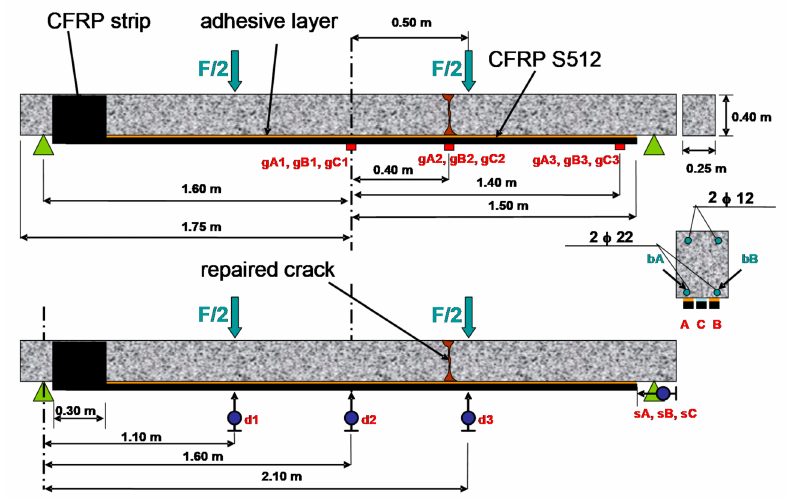
Figure 7. The test